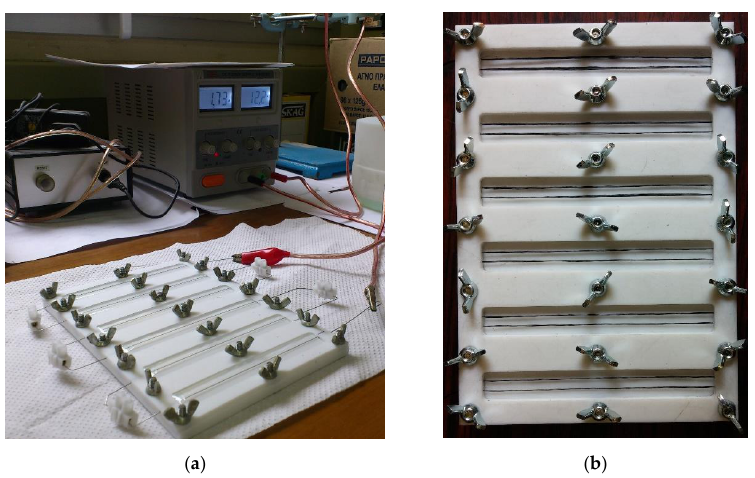
Figure 10. Experimental setup for ( a ) single Kanthal fiber specimens and ( b ) double carbon fiber specimens.